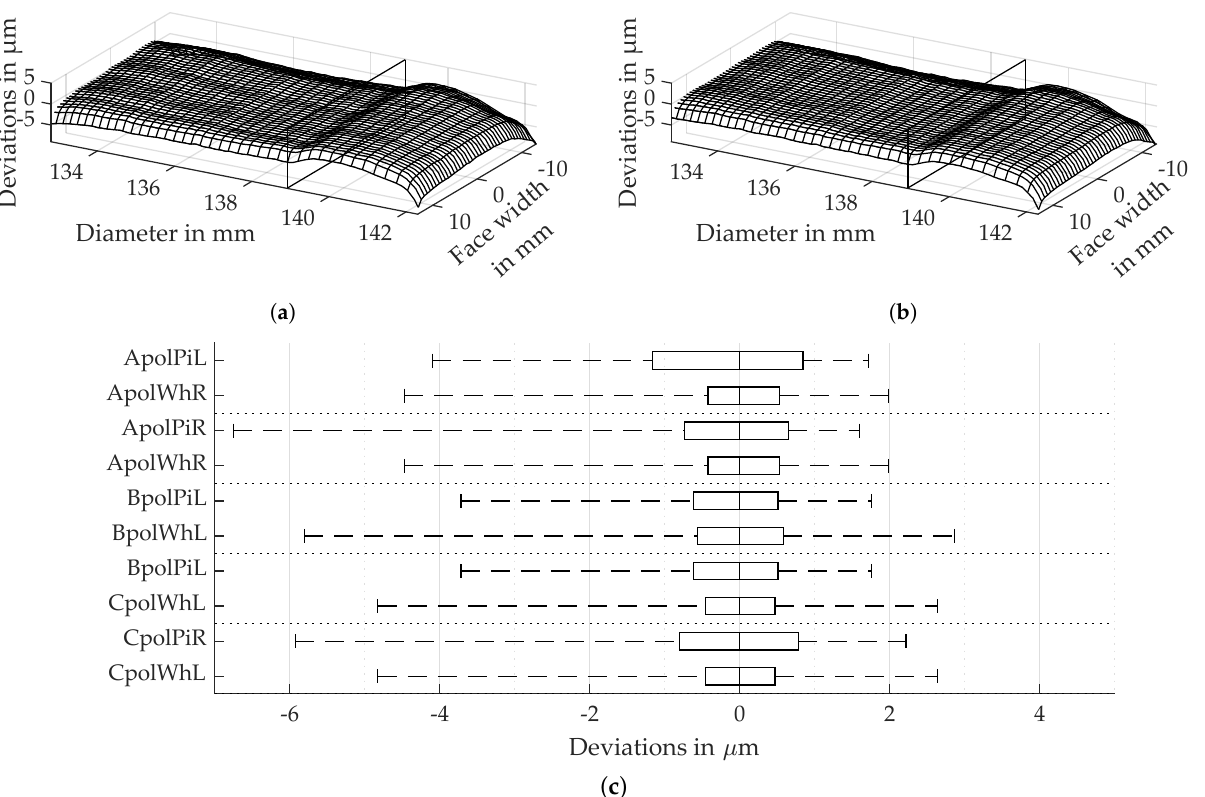
Figure 11. Deviations for polish grinding. ( a ) Flank of gear BpolPiL at tooth nr. 17. ( b ) Median of all teeth of gear BpolPiL. ( c ) Box plot of the deviations in the gear